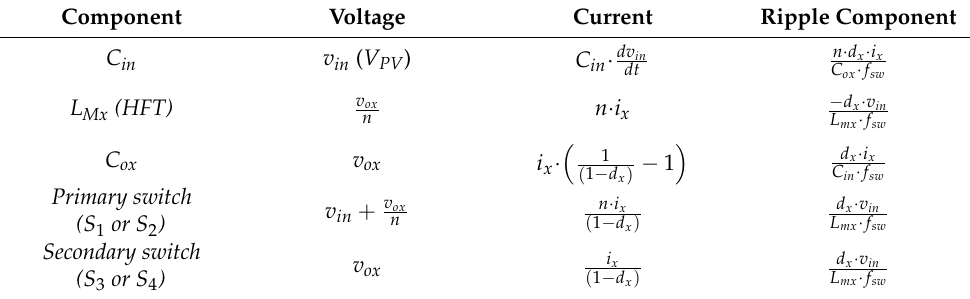
Table 2. Voltage and current